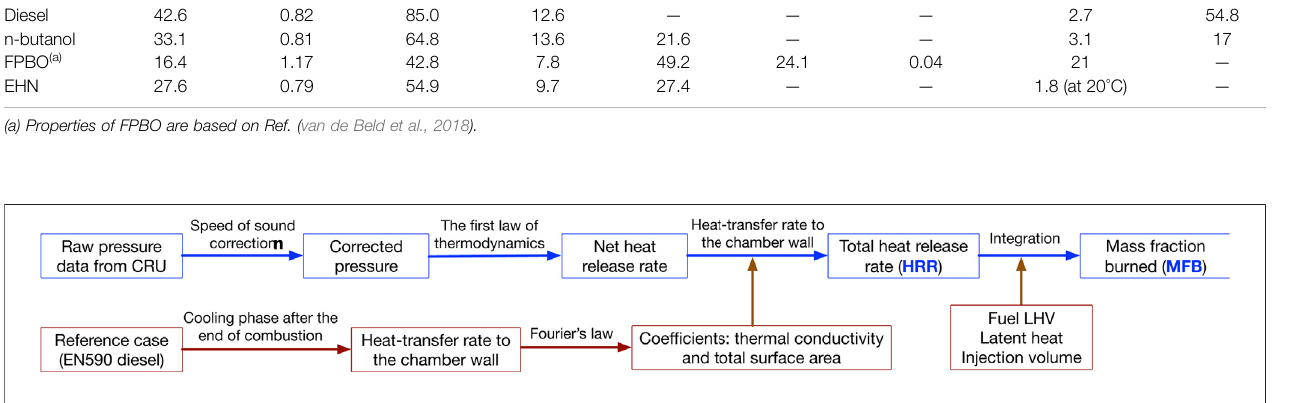
FIGURE 2 | Flow chart of data processing.